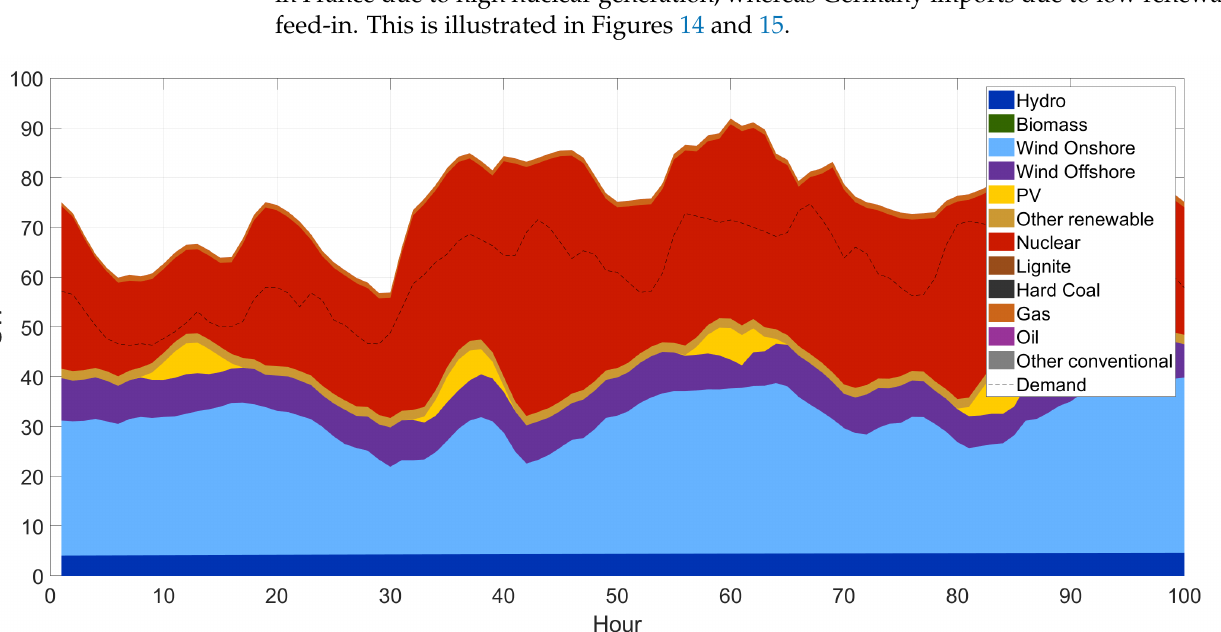
Figure 14. Generation and demand in